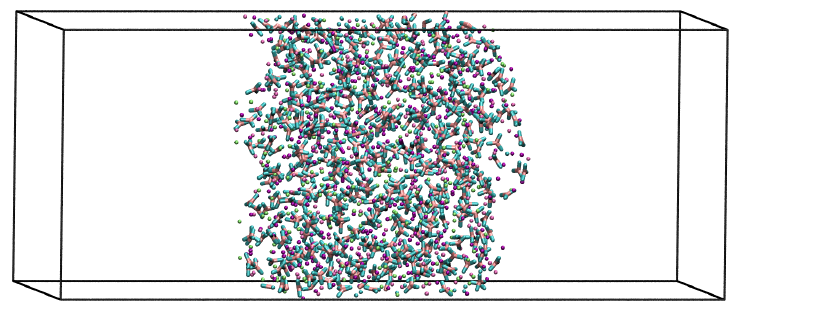
Figure 1 Snapshot of the LiNaKCO 3 simulation cell. An example the slab and interfaces studied in this work.